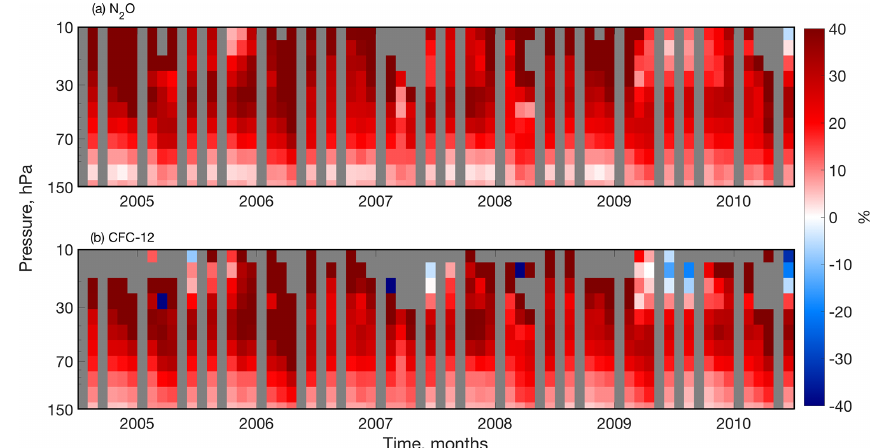
Figure 9. A monthly time series of the average relative differences between the model and the measurements (CMAM30HR minus ACE- FTS, divided by ACE-FTS), as in Fig. 6c for (a) N 2 O and (b) CFC-12 in the Northern Hemisphere (60–90 ◦ N) between June 2004 and May 2010. The grey regions indicate where no data are available.